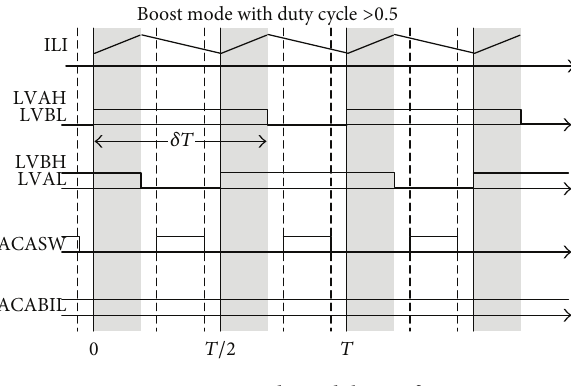
Figure 6: Boost mode modulation, 𝛿 ≥ 0.5